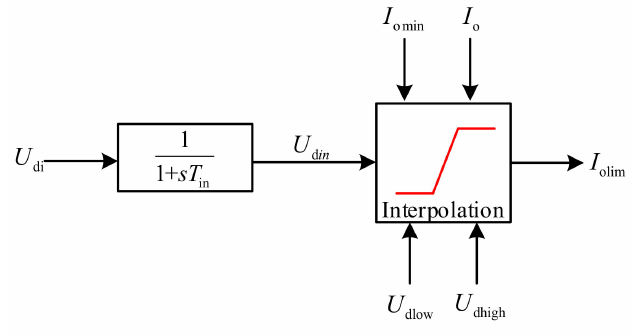
Figure 9. Mathematical model of the